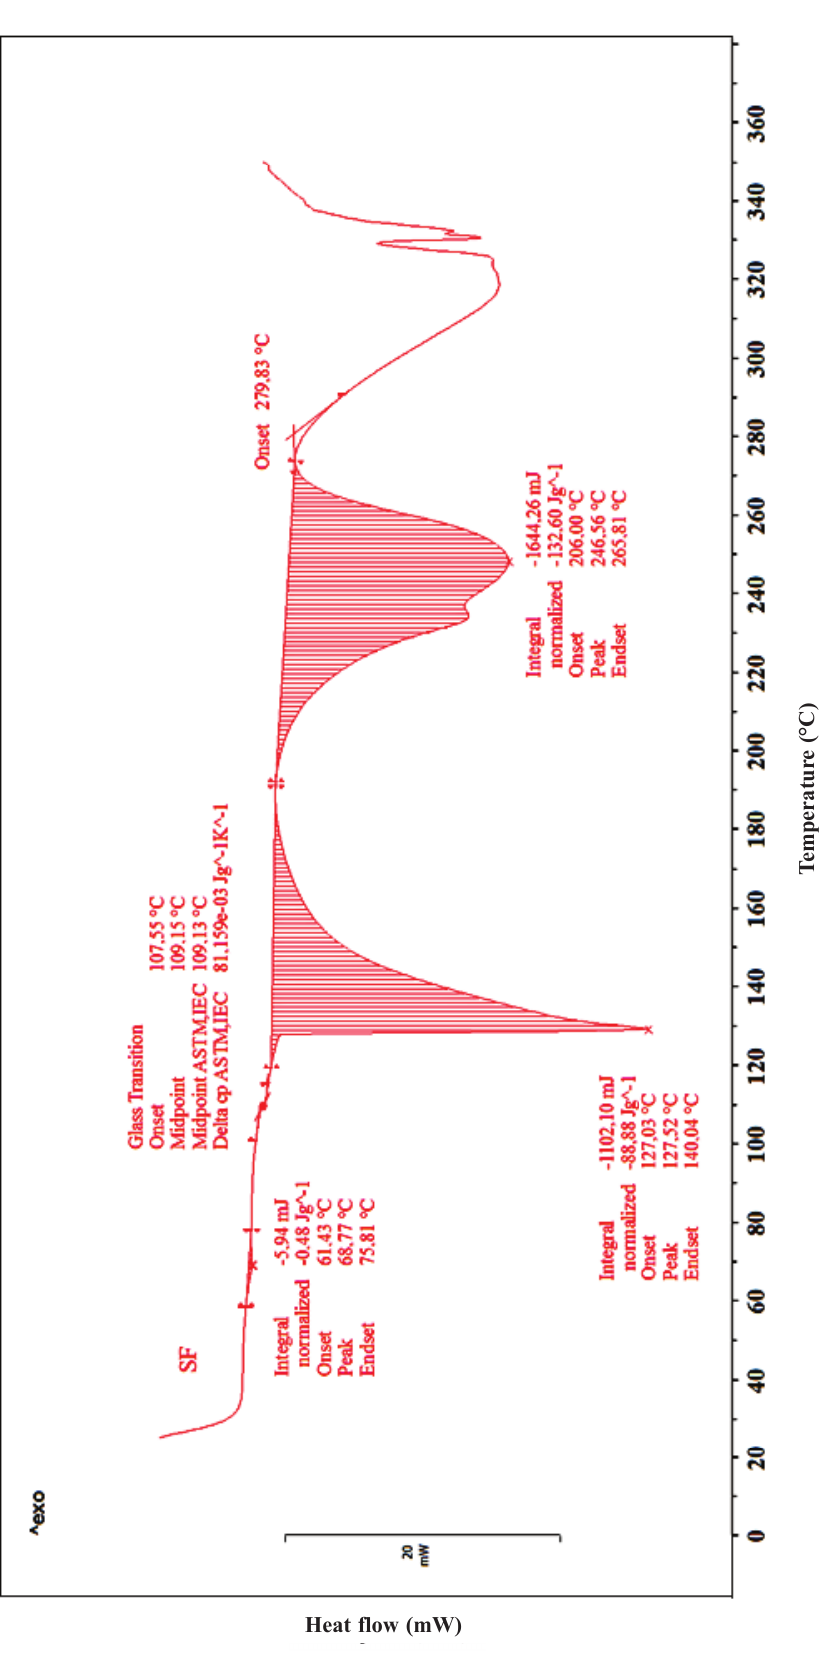
Fig. 4 – DSC curves of silk fibroin powder during